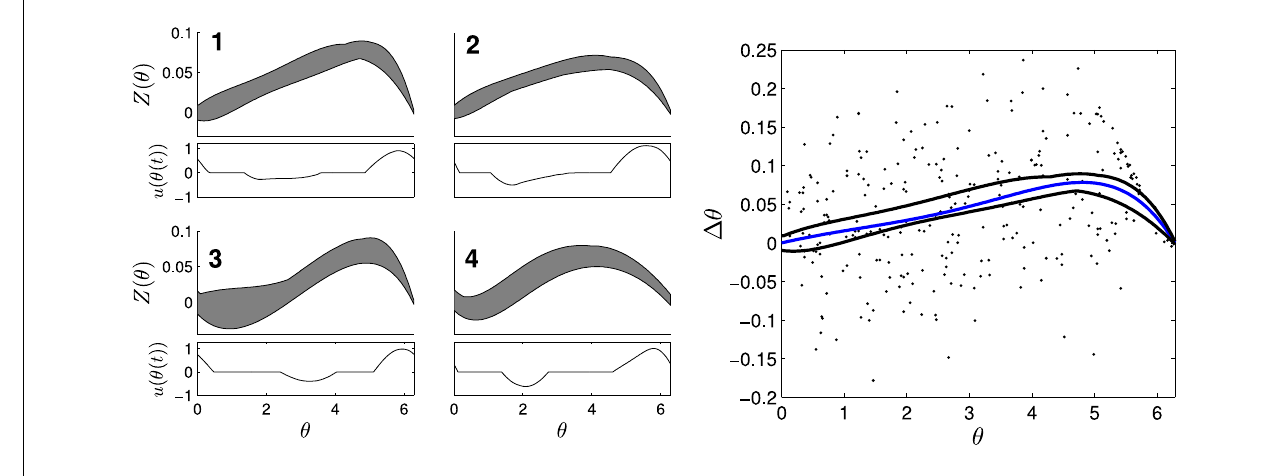
directly below. On the right panel, a PRC (blue) calculated from individual measurements of 1θ/ Q (dots) from a CA1 pyramidal neuron fits within the black curves of envelope 1.